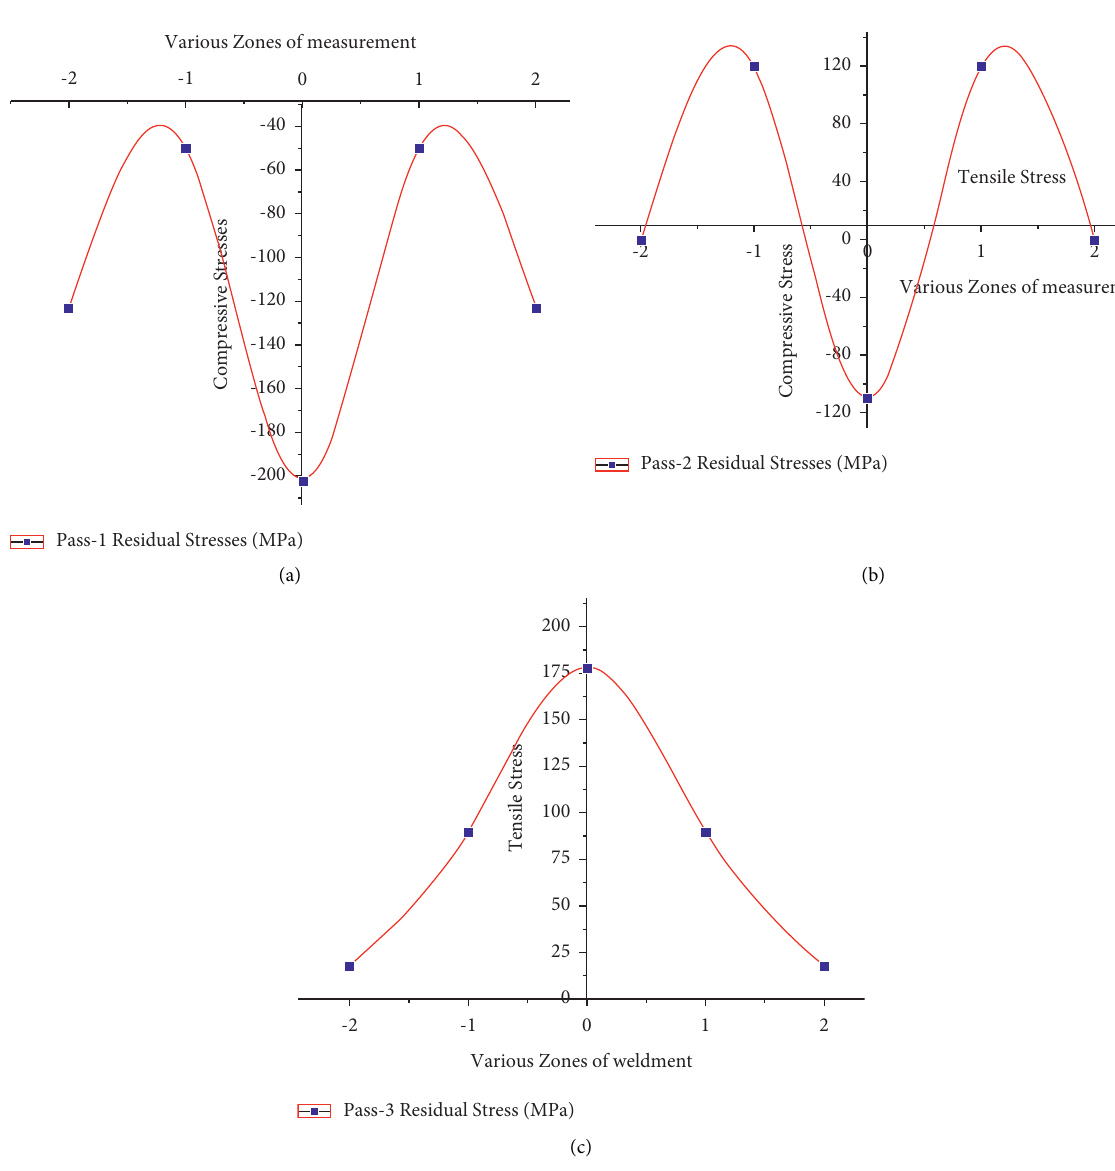
Figure 13: Distribution of residual stress using FEA. (a) Weld pass-1. (b) Weld pass-2. (c) Weld pass-3.